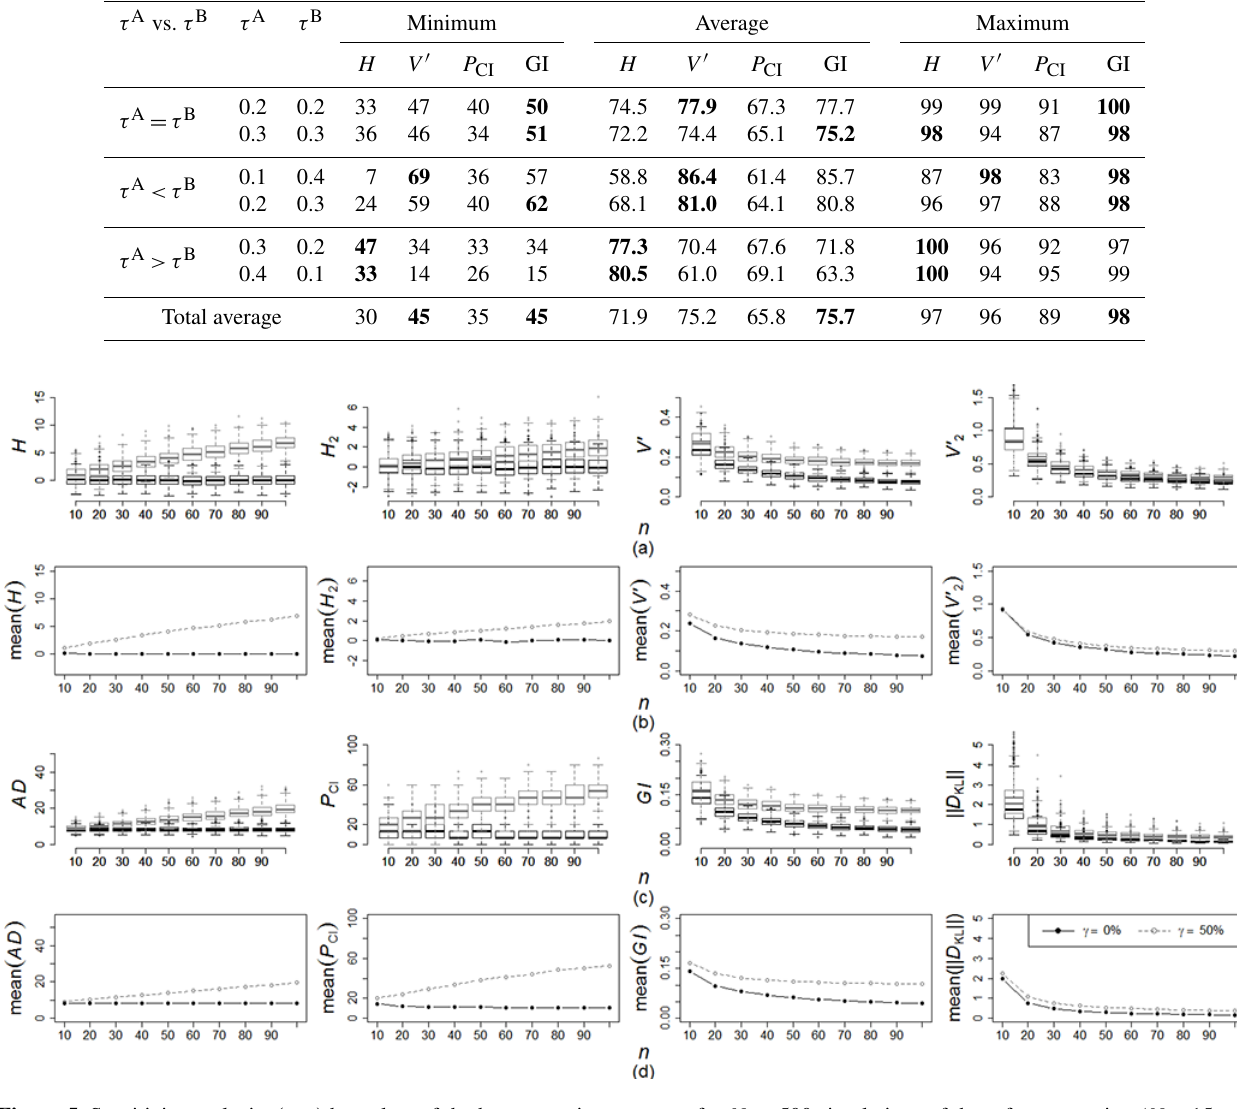
Figure 5. Sensitivity analysis: (a, c) box plots of the heterogeneity measures for N s = 500 simulations of the reference region ( N = 15 and τ R = 0.2), for a heterogeneity rate γ = 0% and γ = 50%, varying the data length n ; and (b, d) comparison of the corresponding mean for γ = 0% and γ =